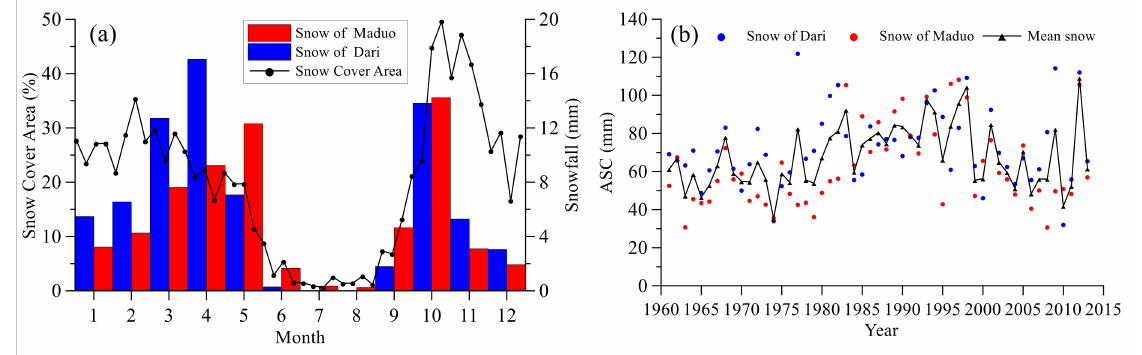
Figure 6. ( a ) Intra-annual variation of snow and snow cover area; ( b ) inter-annual variation of annual accumulative snow in cold season